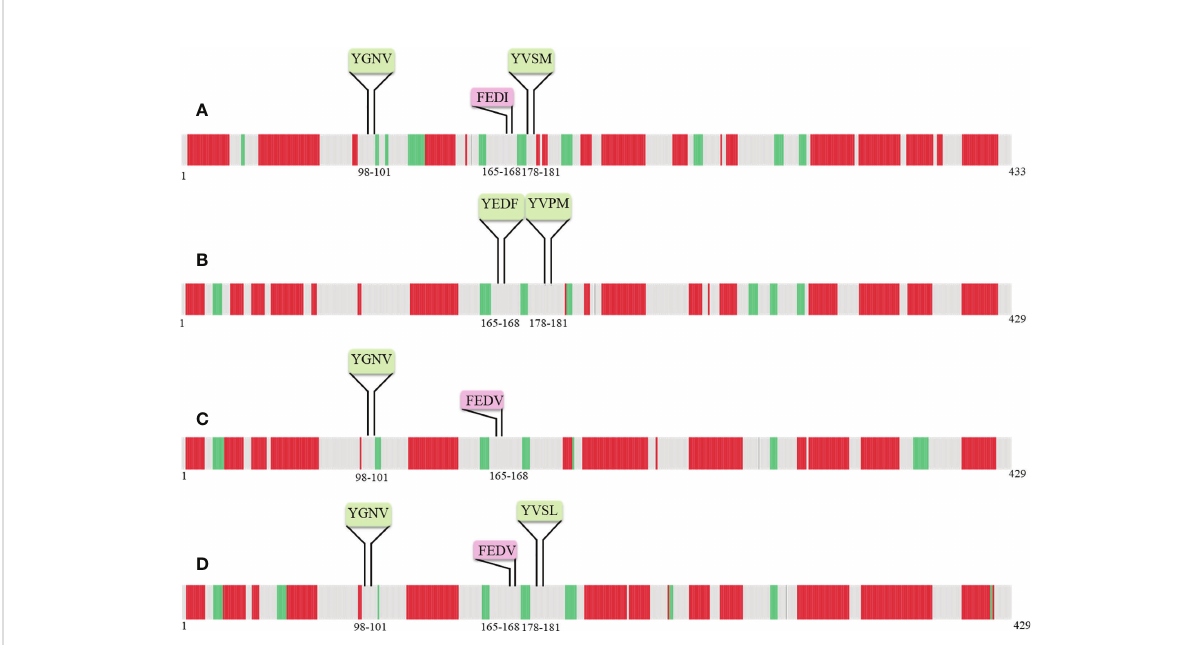
FIGURE 5 Pictorial representation of secondary structure of (A) PUUV, (B) SEOV, (C) DOBV, and (D) HTNV nucleoprotein sequences. a -helices represented with red color, b -strand represented with green color, while grey color indicated